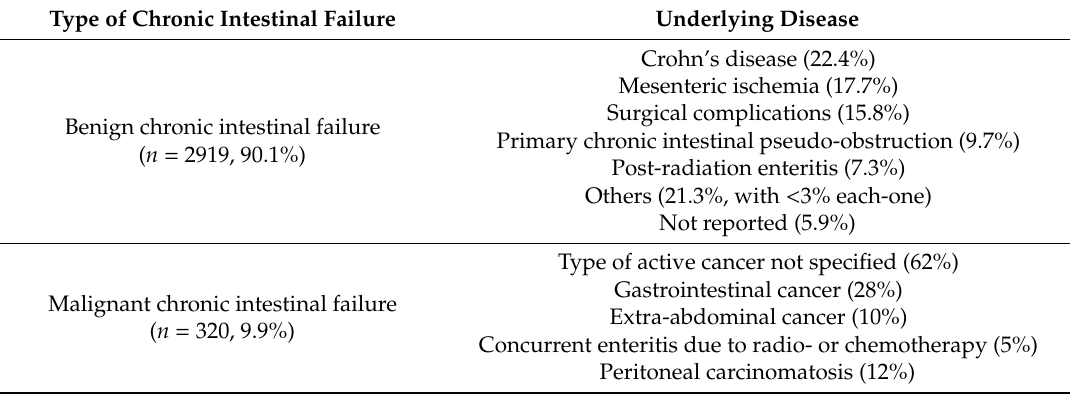
Table 1. Epidemiologic data from 3239 patients with chronic intestinal failure in countries around the world, from Pironi et al.